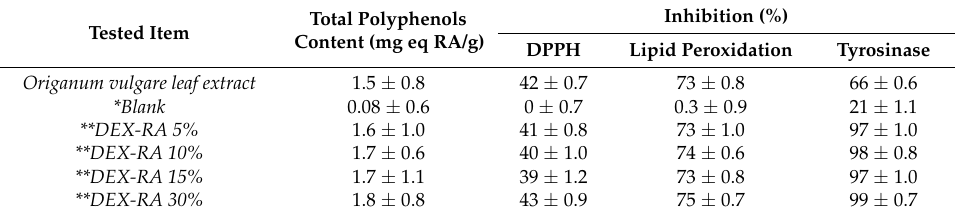
Table 1. Total polyphenols content expressed as mg equivalent of rosmarinic acid per gram of sample and DPPH, lipid peroxidation and tyrosinase inhibition expressed as percentage (mean value ± st.